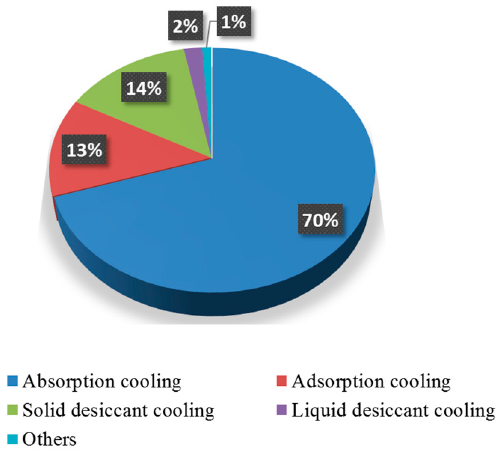
Figure 2. Solar cooling technology by categories.